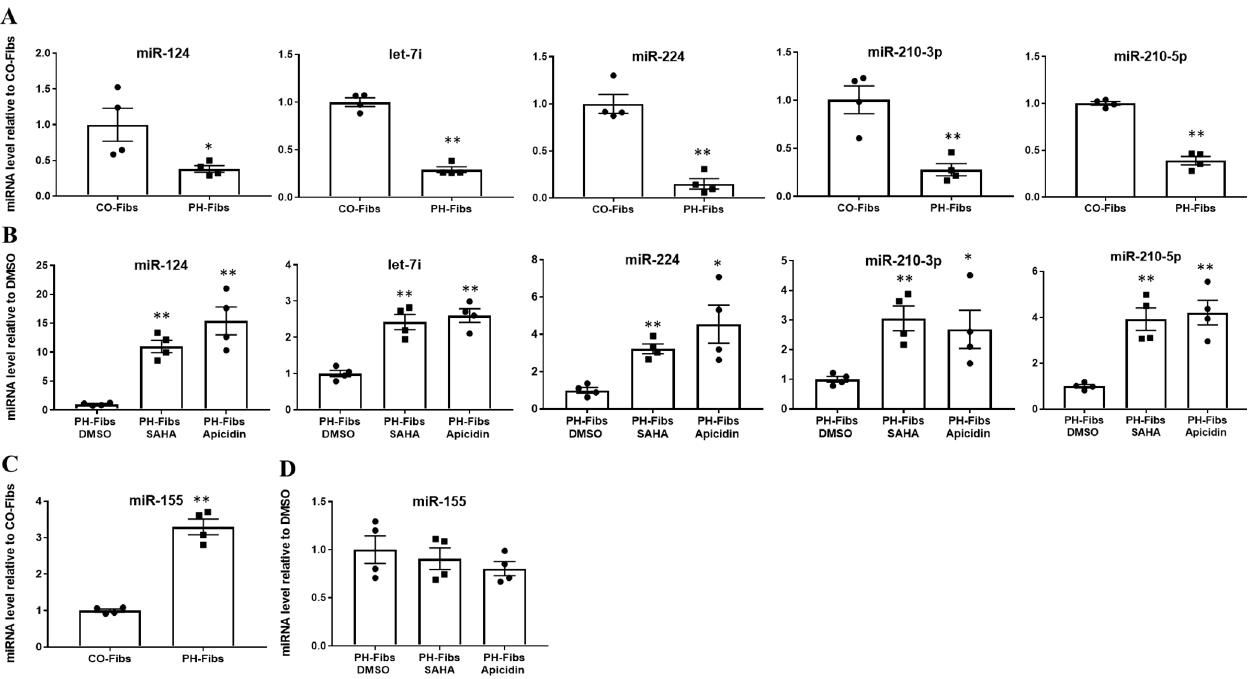
Figure 1. Besides miR-124, human PH-Fibs exhibit significantly decreased levels of let-7i, miR-224 and miR-210, which can be increased by HDACi. qRT-PCR analysis of mature miR-124, let-7i, miR-224, miR-210 and miR-155 levels in human CO- ( n = 4) and PH-Fibs ( n = 4) ( A , C ) or in human PH-Fibs treated with DMSO (control) or HDACi (SAHA and apicidin) for 48 h ( B , D ). Data are presented as mean ± S.E.M, * p < 0.05, ** p < 0.01 PH-Fibs vs. CO-Fibs or PH-Fibs treated with HDACi vs.